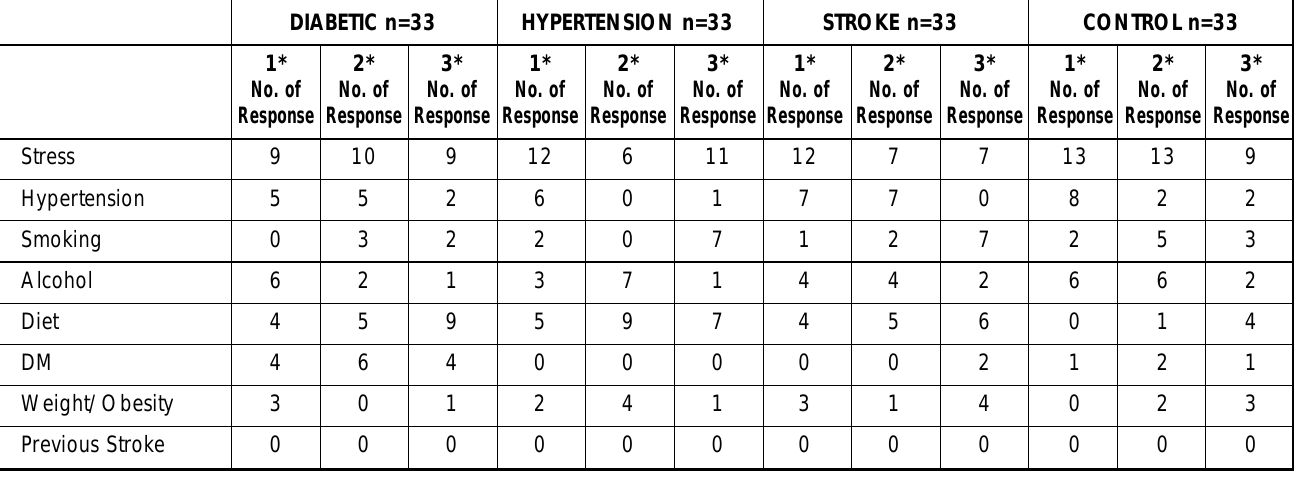
Table 4: Ranking of the most important risk factors in the diabetic, hypertensive, stroke and control